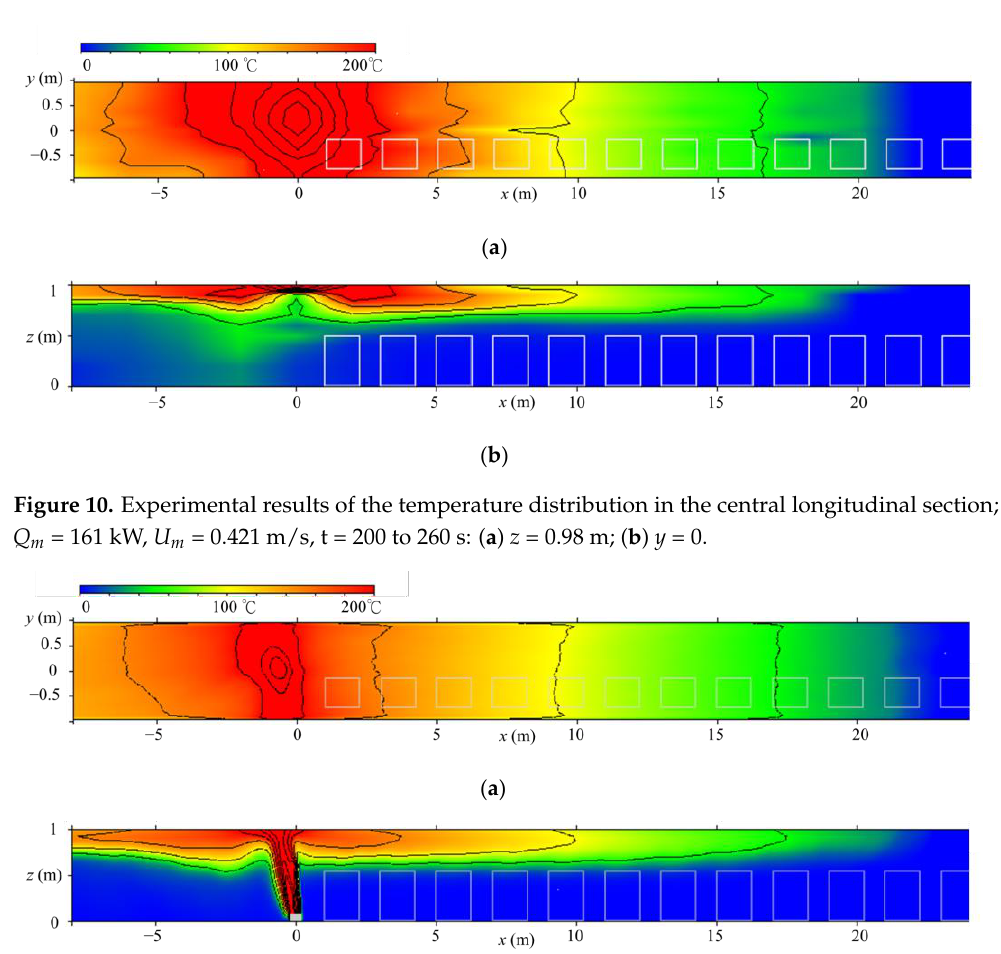
Figure 12. Tilt of the fire plume due to the upstream longitudinal velocity.